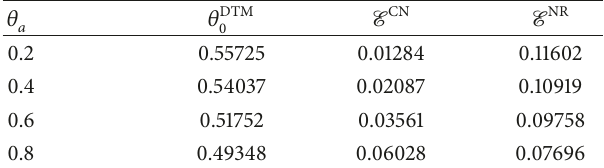
Table 5: Numerical solutions obtained for DTM and the maximum error computed between the DTM solution and the respective numerical solutions obtained, where E CN = max | CN sol − DTM sol | and E NR = max | CN NR sol − DTM sol | , for varied values of N 𝑐 . 𝜃 𝜃 DTM 𝑎 0